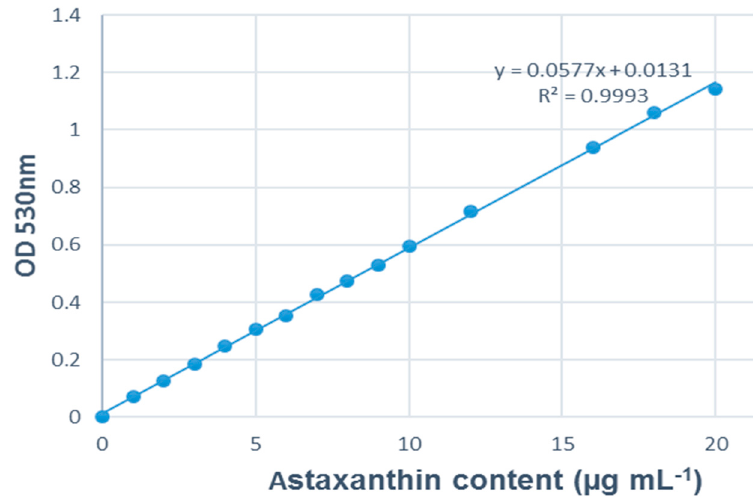
Figure 4. Astaxanthin standard calibration curve for spectrophotometry.